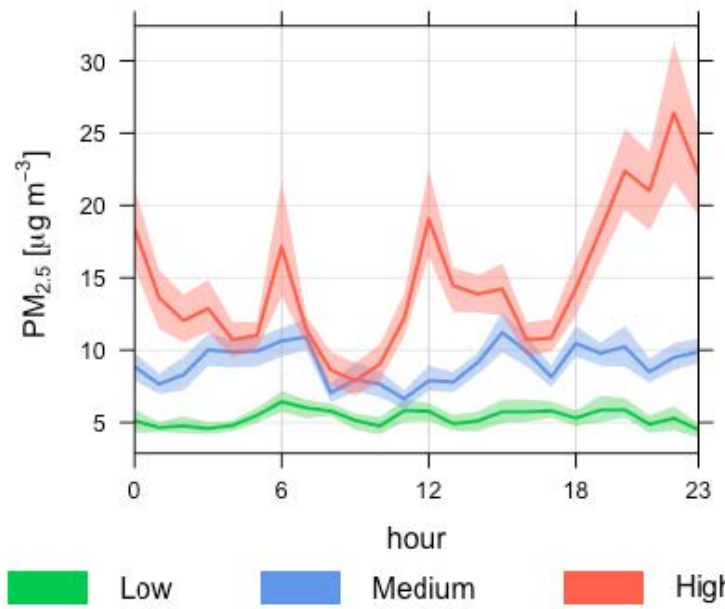
Figure 2. Time variation plot of PM 2.5 (µg/m 3 ) concentrations from the three air monitoring sites within the urban classes, low, medium, and high. PM 2.5 at corresponding time of day was averaged for each sampling period. Mean is shown with a solid line and 95% confidence interval in the mean is shown with a transparent area.